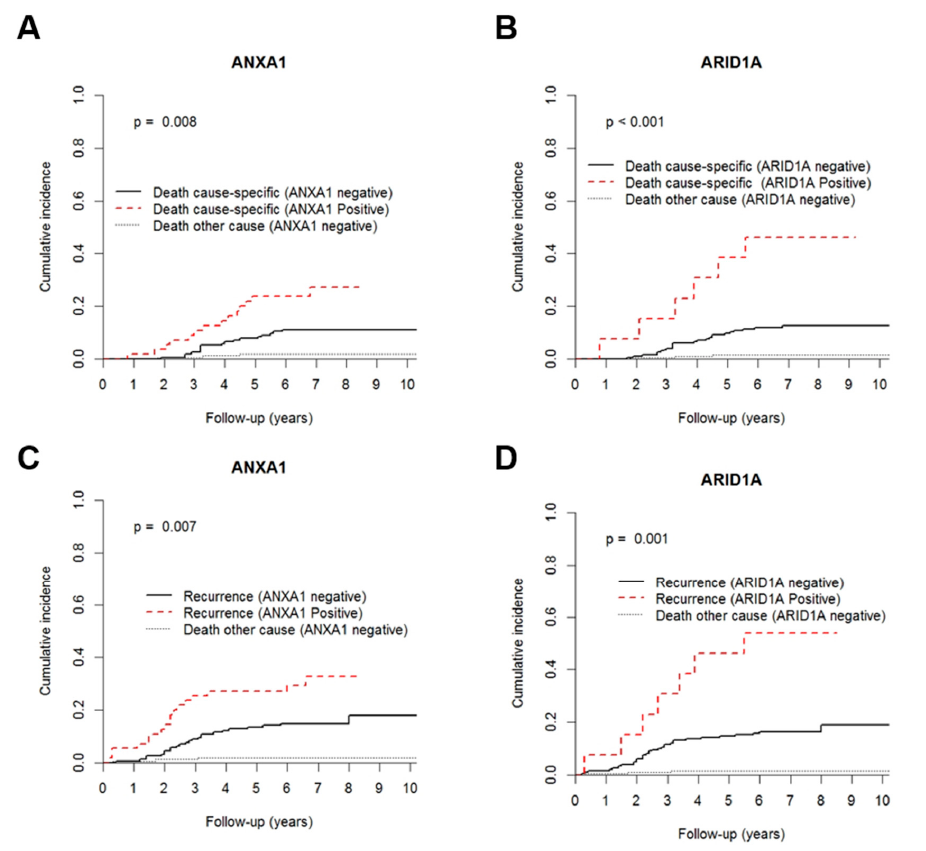
Figure 4. Cumulative incidence function plots according to ( A , C ) ANXA1 and ( B , D ) ARID1A immunoexpression. Dashed red line and full black line represent positive / high expression and negative / low expression for ANXA1 and ARID1A immunoexpression, respectively. p values obtained by Gray’s test for breast cancer mortality ( A , B ) and relapse ( C , D ). Table 3. Cox regression models assessing the potential of clinical variables and ANXA1 immunoexpression in the prediction of breast cancer mortality.